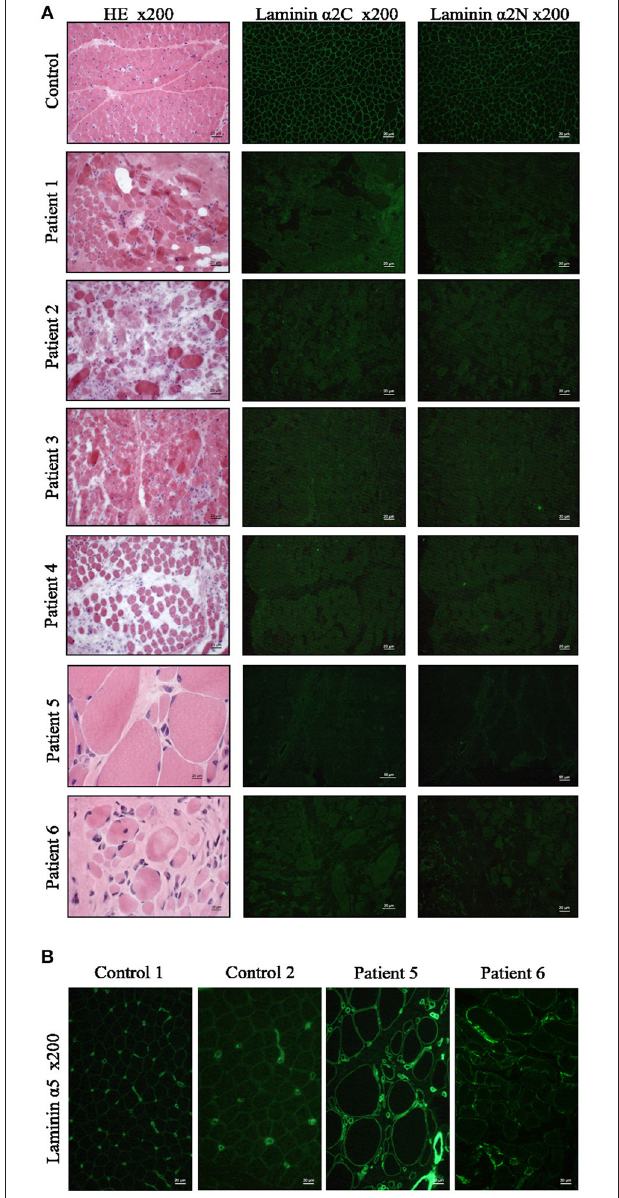
FIGURE 2 | Muscle biopsy findings in MDC1A-patients included in the study. (A) Muscle biopsy cryostat sections stained with hematoxylin and eosin (HE) and immunofluorescence staining with anti-laminin-211 antibodies reveals absent immunoreactivity in the patient-derived sections. (B) Immunofluorescence staining of muscle cryostat sections with anti-laminin-511 antibody reveals in increased immunoreactivity in muscle biopsies of MDC1A-patients as indicated for two representative cases shown here. Ctrl, control muscle; numbers 1, 2, 3, 4, 5, and 6 refer to muscle biopsies derived from MDC1A-patients with the corresponding patient numbers listed in Table 2